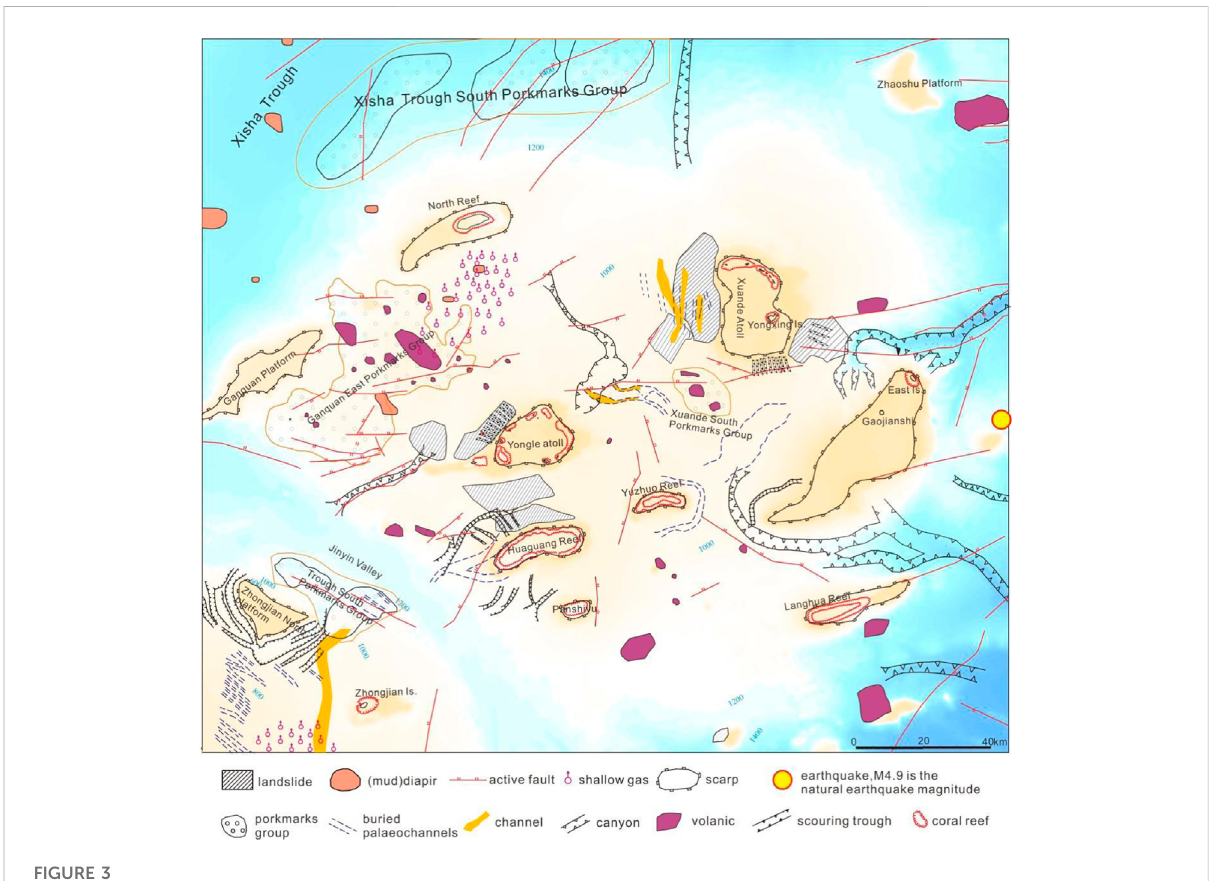
FIGURE 3 Geological distribution map of environmental hazards in Xisha Sea